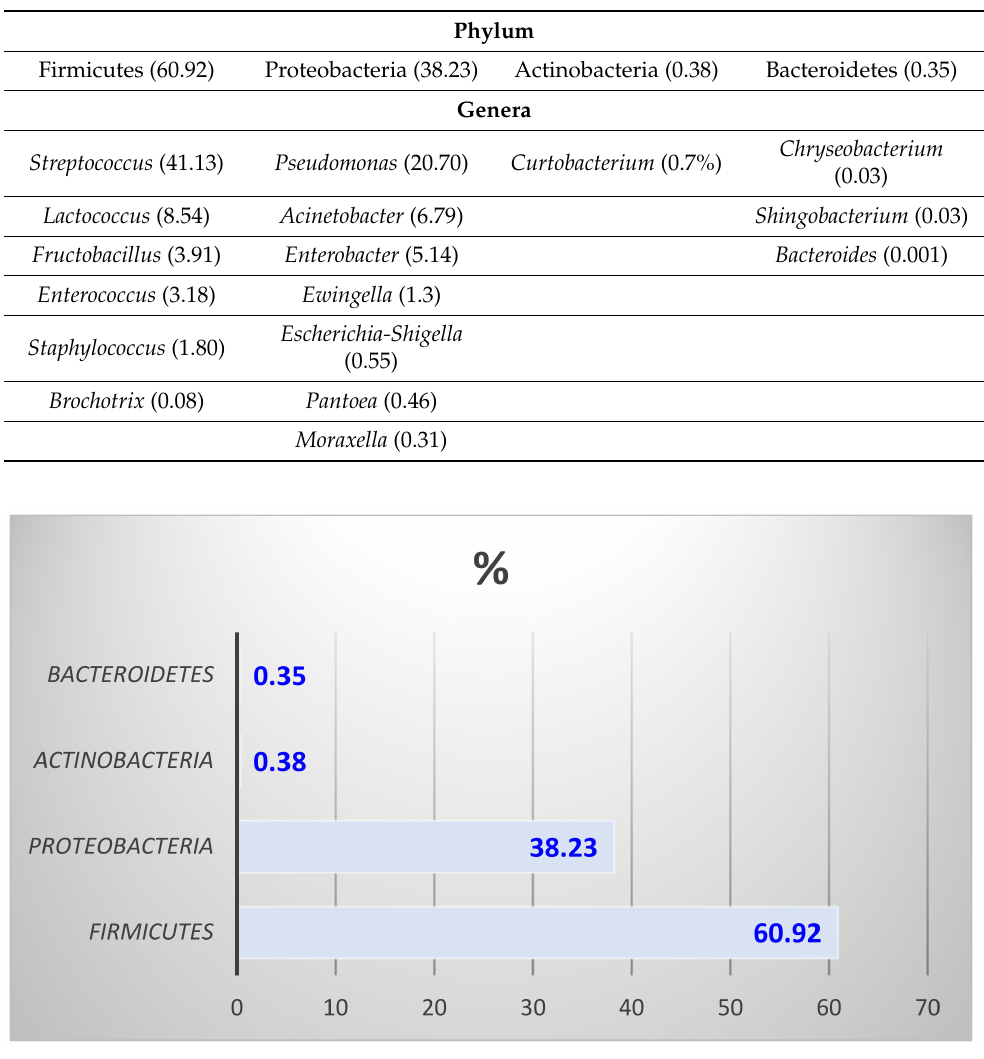
Figure 2. Phyla detected in Slovak ewe’s lump cheeses (in